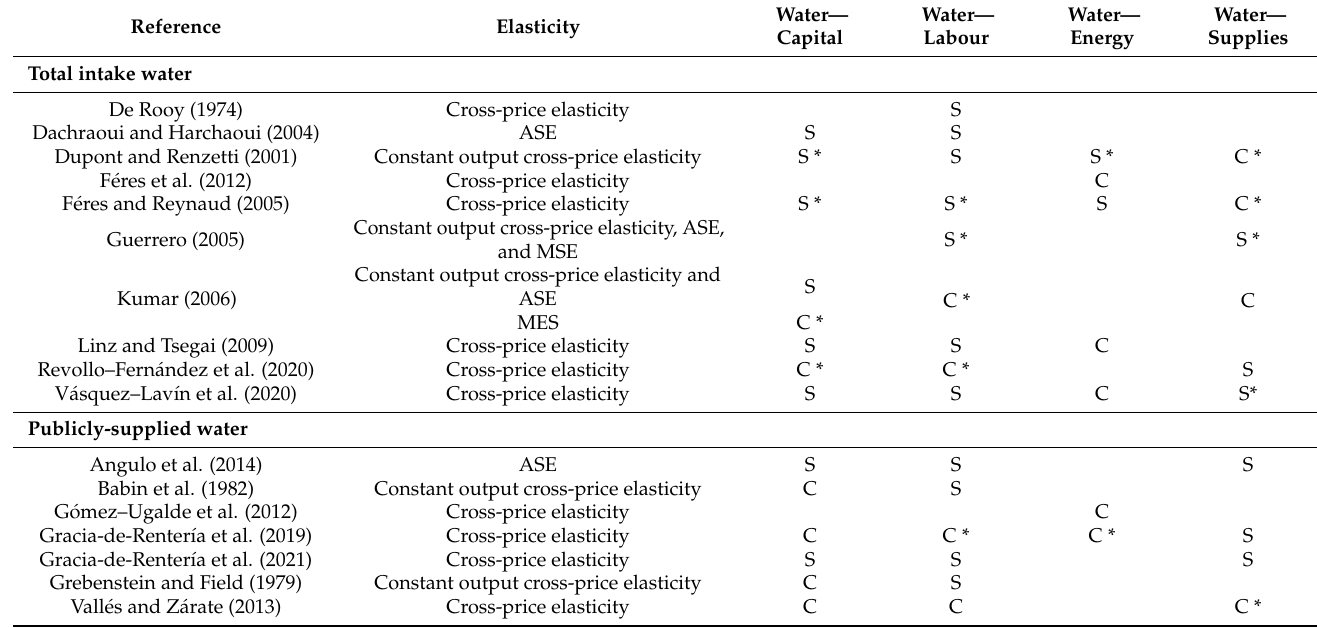
Table 5. Relationship between water and other